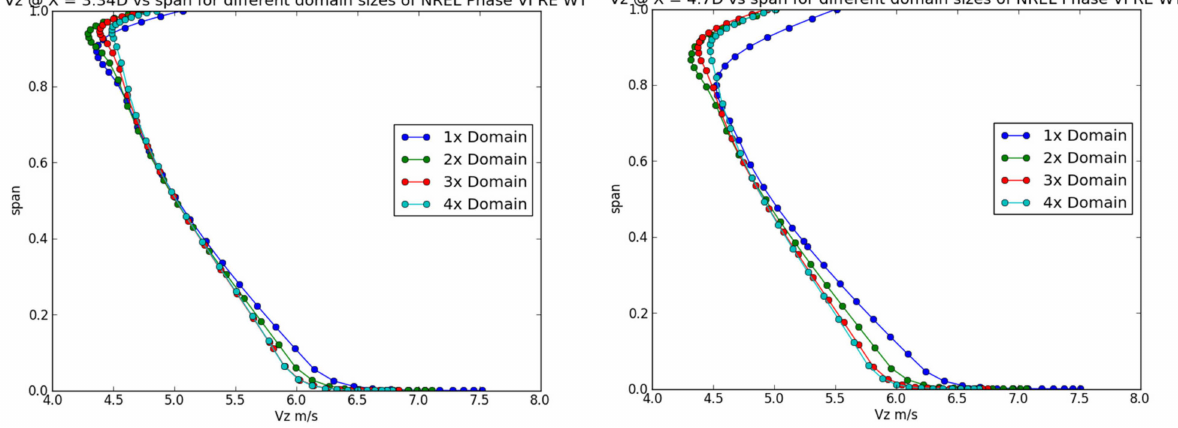
Figure 29. Wakes downstream of the wind turbine rotor for all four domains. Figure 30 plots the axial velocity deficit contours in cross planes downstream and turbulent viscosity ratio in the Y symmetry plane. As the turbulent viscosity ratio increases,